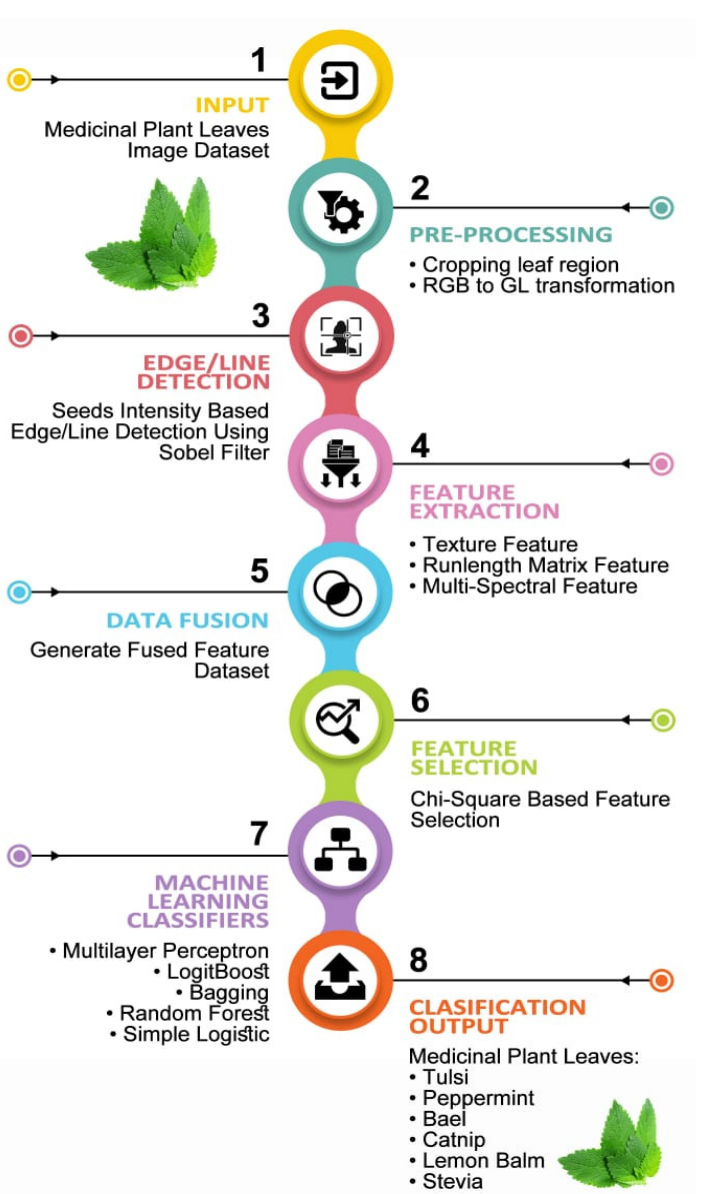
Figure 5. Proposed framework for the classification of medicinal plant leaves based on multispectral and texture feature using machine learning approach.